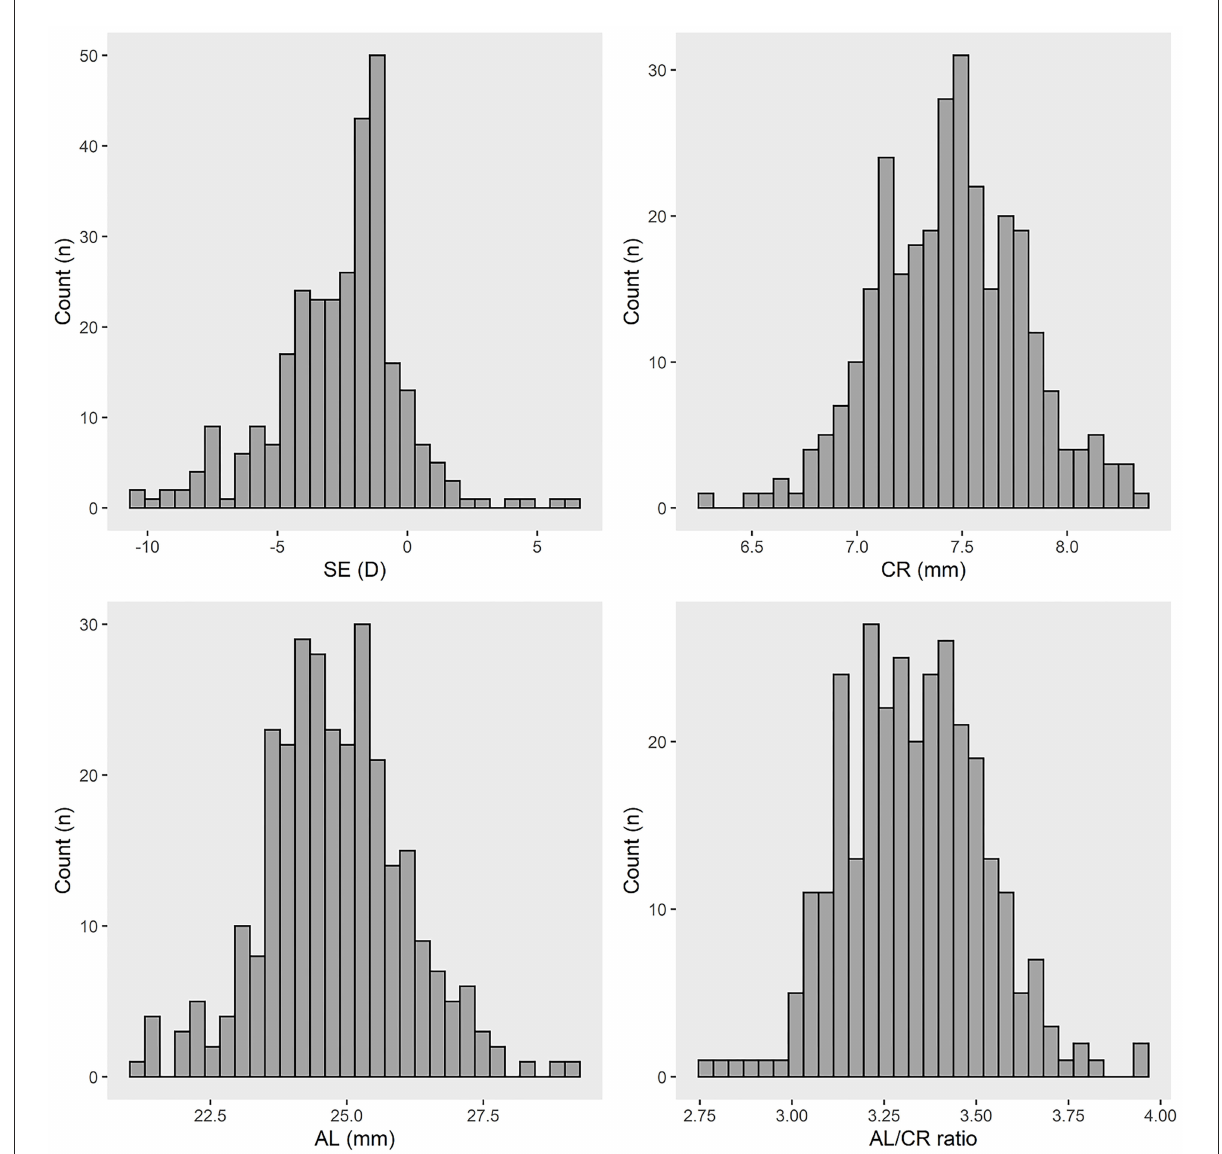
FIGURE1 The refractive parameters of participants in this study. SE, spherical equivalent; CR, corneal radius; AL, axial length; AL/CR ratio, axial length/corneal radius ratio; D, diopter.